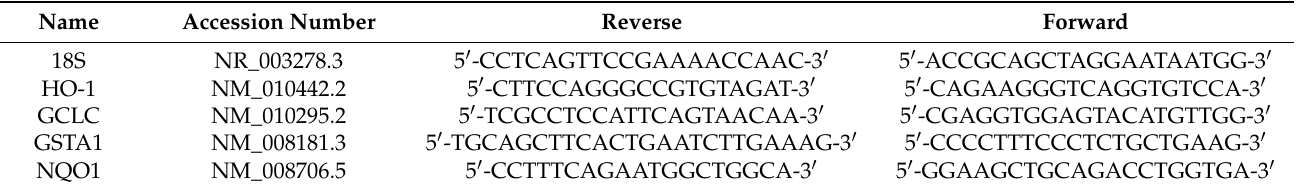
Table 1. Sequences of the primers used for quantitative real-time